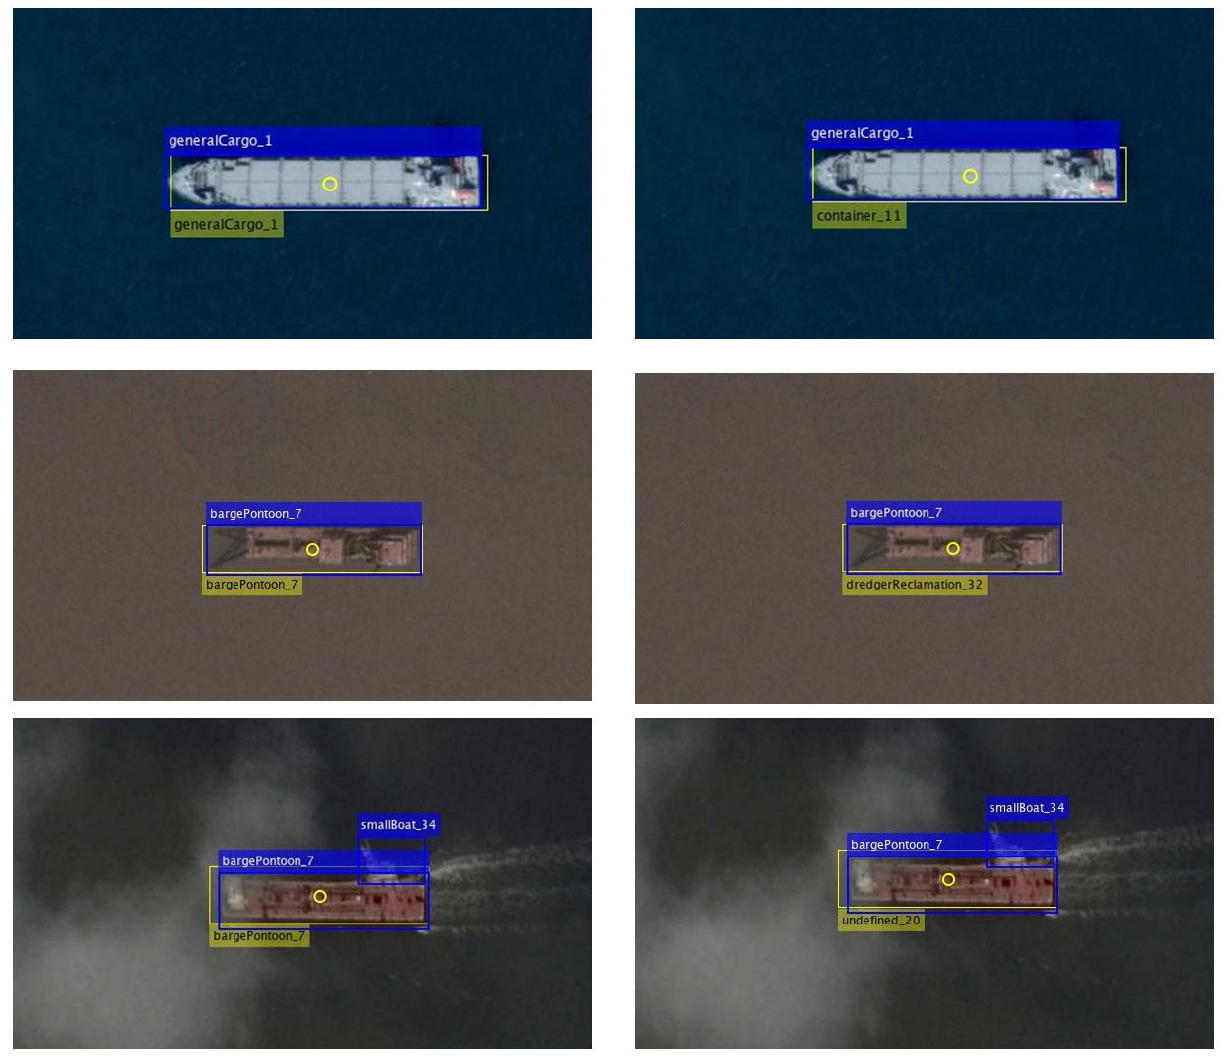
Figure 5. Comparative visuals of HieD (left column) and YOLOv4 (right column) for offshore regions (blue labels are the ground truth and yellow labels with a circle at the center of bBox are the results of HieD or YOLOv4).